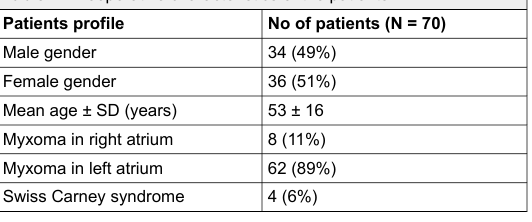
Table 1: Preoperative characteristics of the patients.